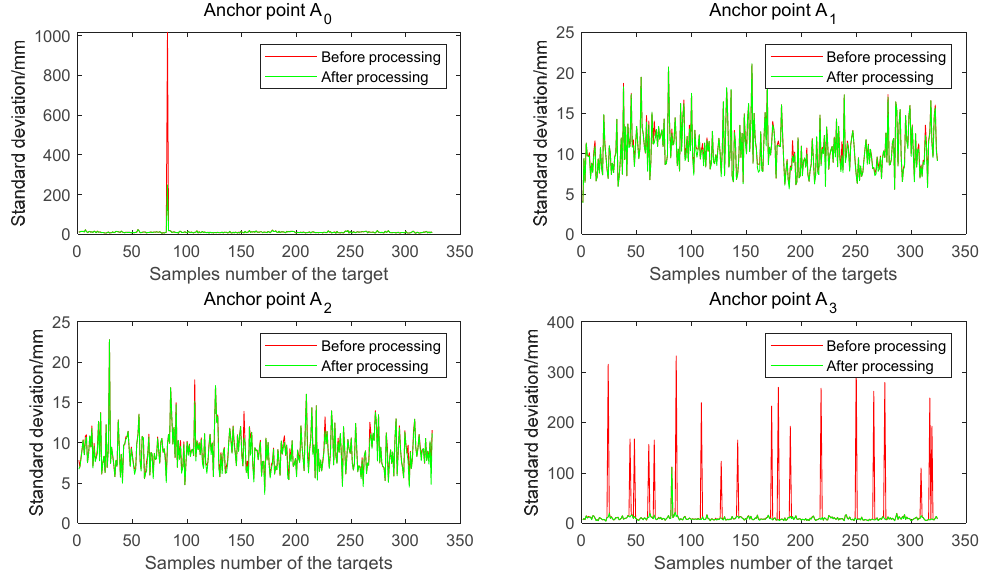
Figure 5. The standard deviation comparison of the samples before and after processing without signal interference.